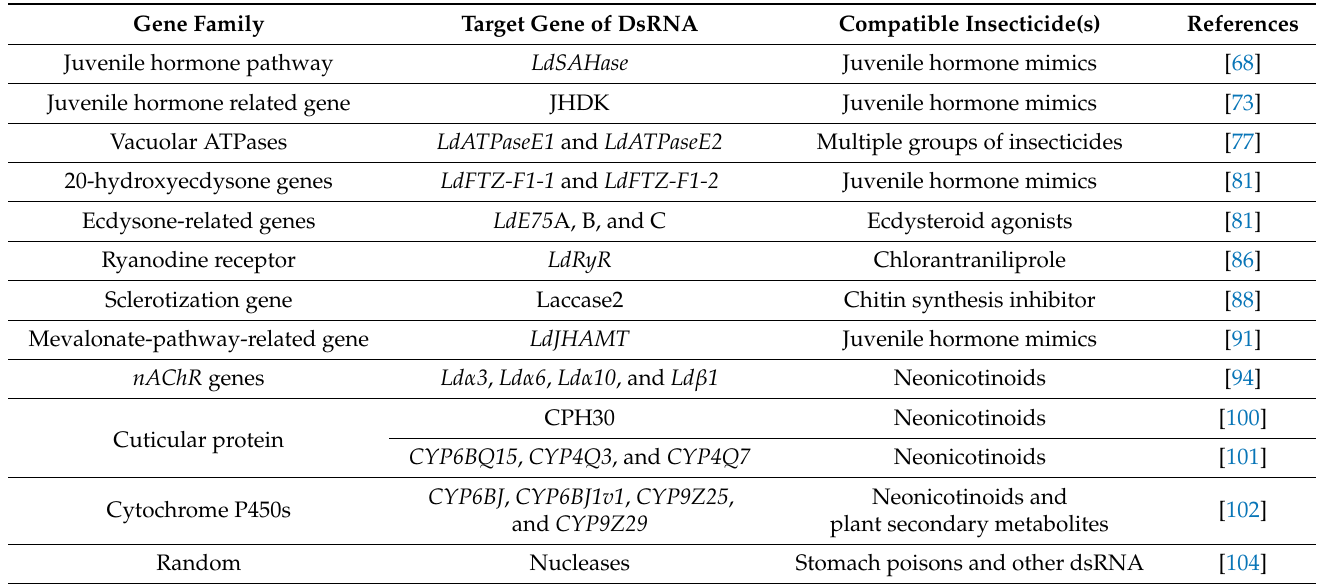
Table 2. Target genes of dsRNA which can be used to synergize